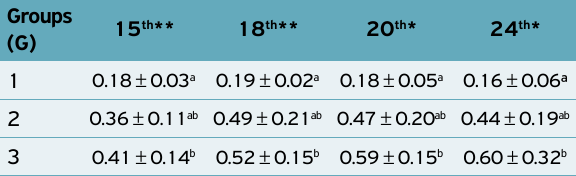
Table 3. Mean of macroscopic (M) and microscopic (m) lesion scores in unvaccinated (G1) hens and vaccinated with one dose at 8 week of age (G2) and two doses at 8 th to 11 th week of age (G3) in differents phases of the